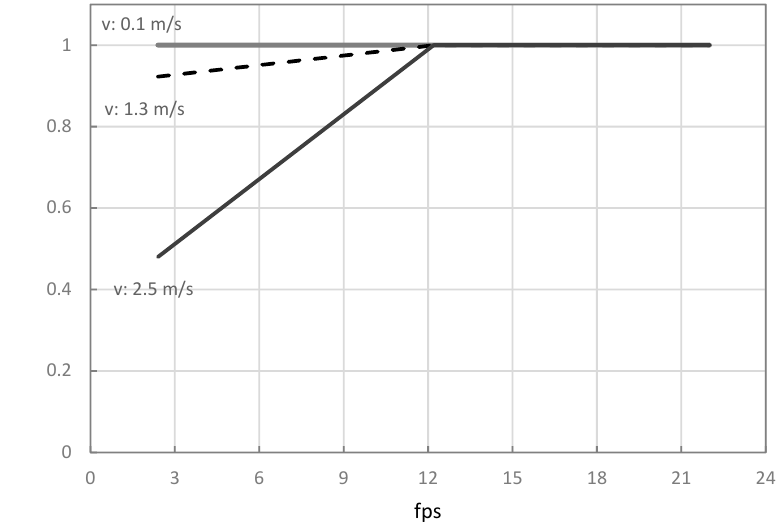
Figure 8. Simulated plant hill detection rates of the vision system moving at 0.1, 1.3, and 2.5 m/s at different inferencing speeds ( f ps ).